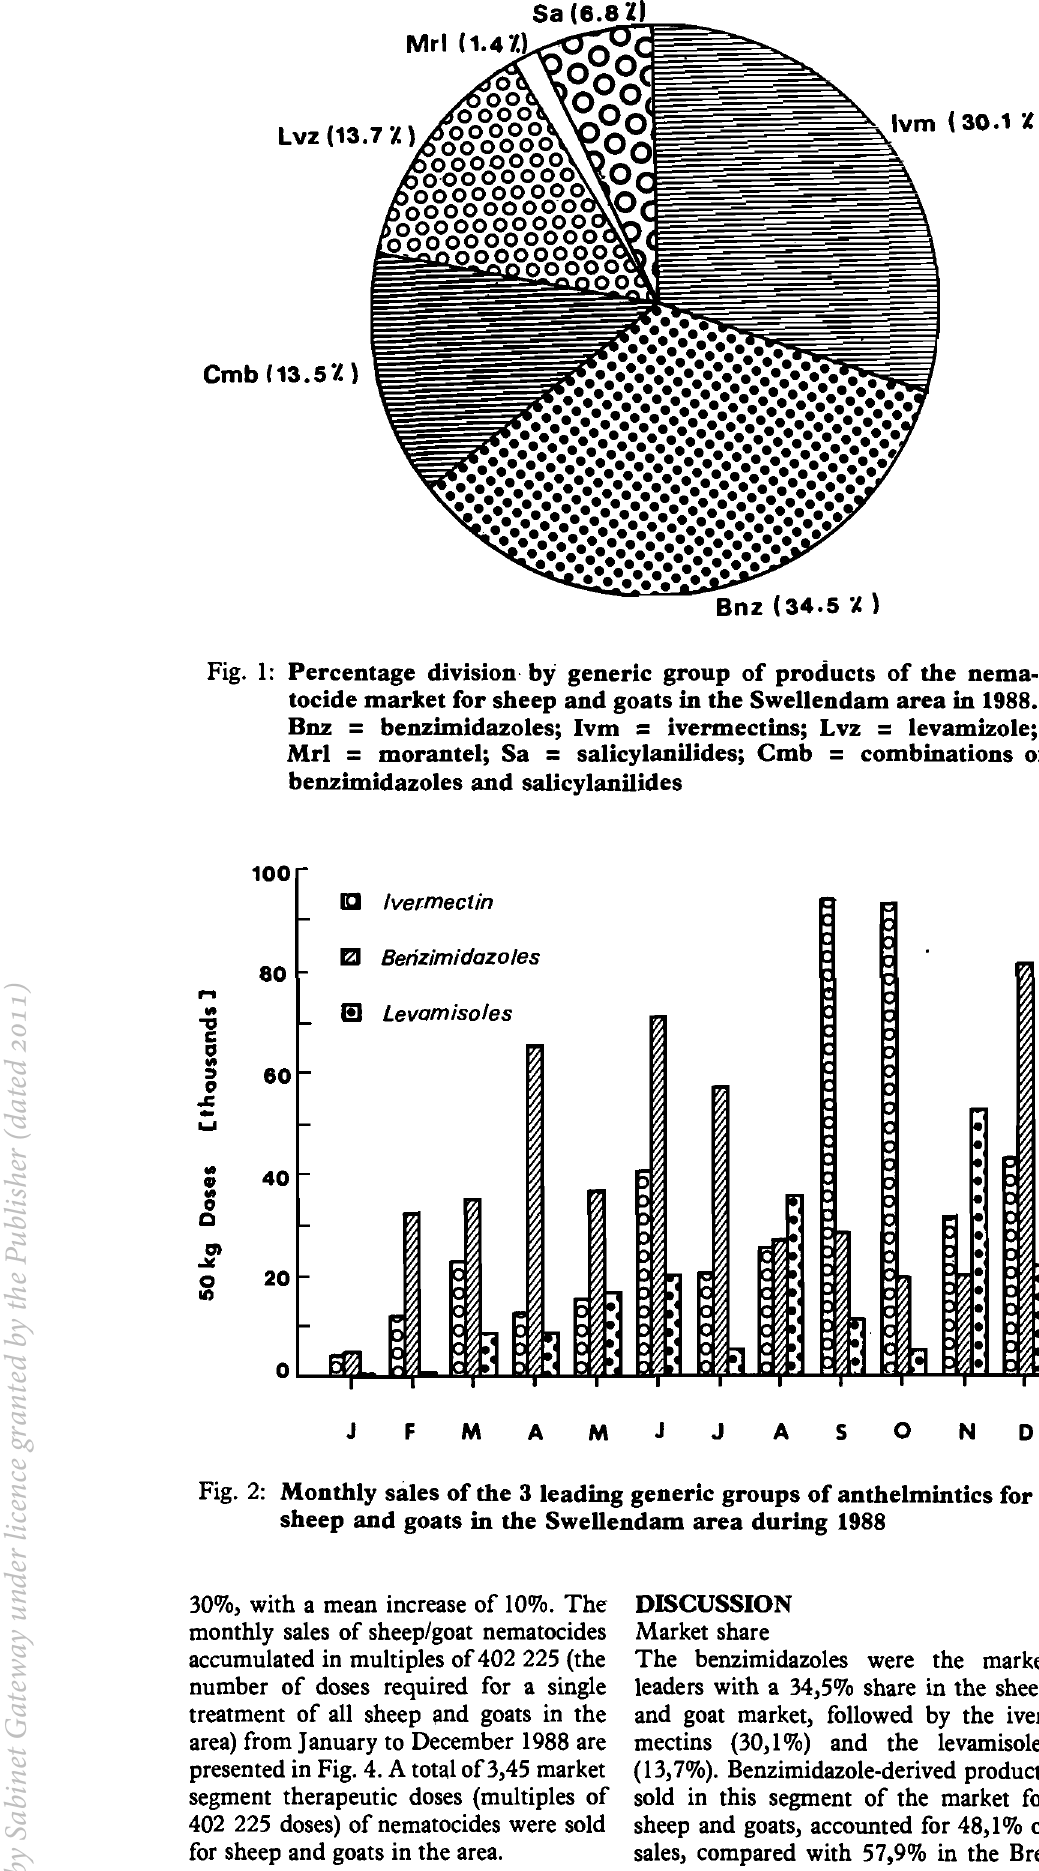
Fig. 2: Monthly sales of the 3 leading generic groups of anthe1mintics for sheep and goats in the Swellendam area during 1988 30%, with a mean increase of 10%. The monthly sales of sheep/goat nematocides accumulated in multiples of 402 225 (the number of doses required for a single treatment of all sheep and goats in the area) from January to December 1988 are presented in Fig. 4. A total of3,45 market segment therapeutic doses (multiples of 402 225 doses) of nematocides were sold for sheep and goats in the